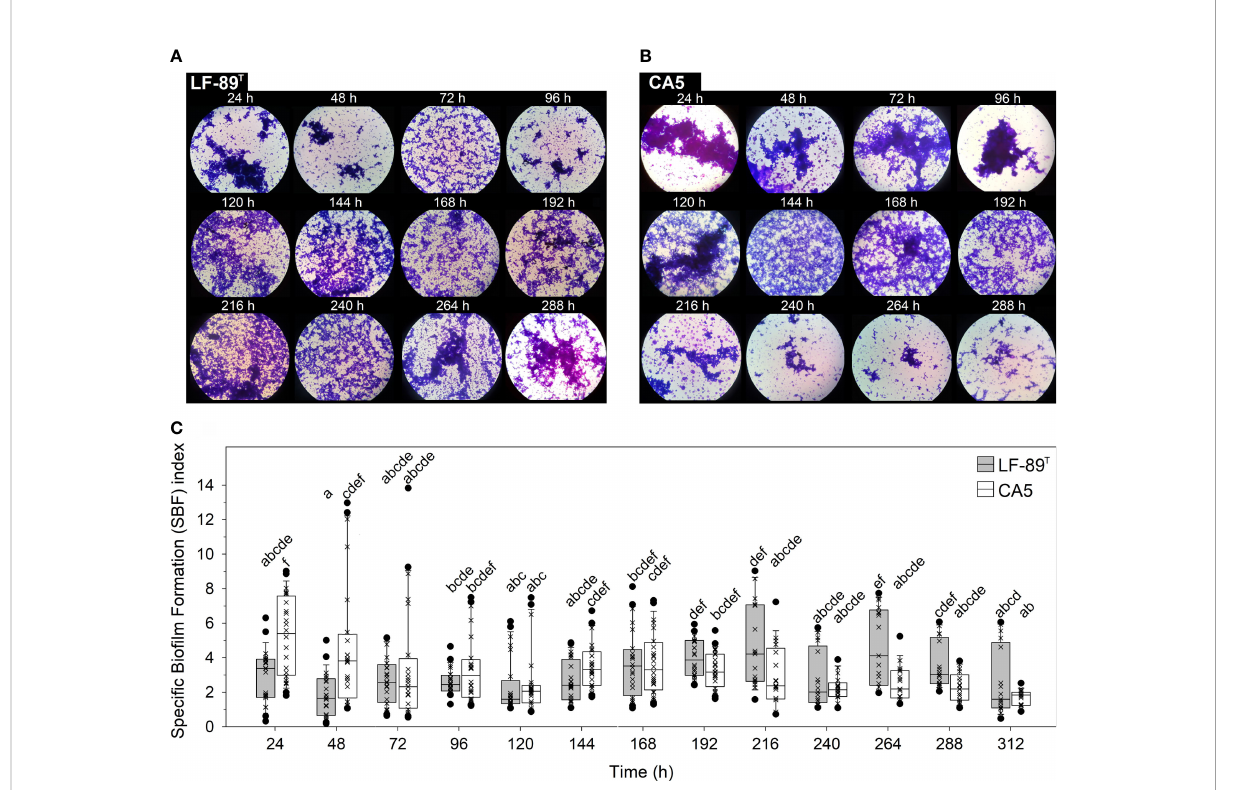
FIGURE 1 Crystal violet-stained bio fi lms and speci fi c bio fi lm formation (SBF) index. The bulk fraction of the bio fi lm structure formed by P . salmonis (A) LF- 89 T and (B) CA5 was visualized under 1,000X magni fi cation. (C) Box plots show the medians, upper/lower quartiles (boxes), value ranges (vertical lines), and extreme values (circles) of SBF index data sets (×). Statistically signi fi cant differences between SBF index boxes (Tukey HSD test; P < 0.05) are indicated with different letters. Data were collected from three independent